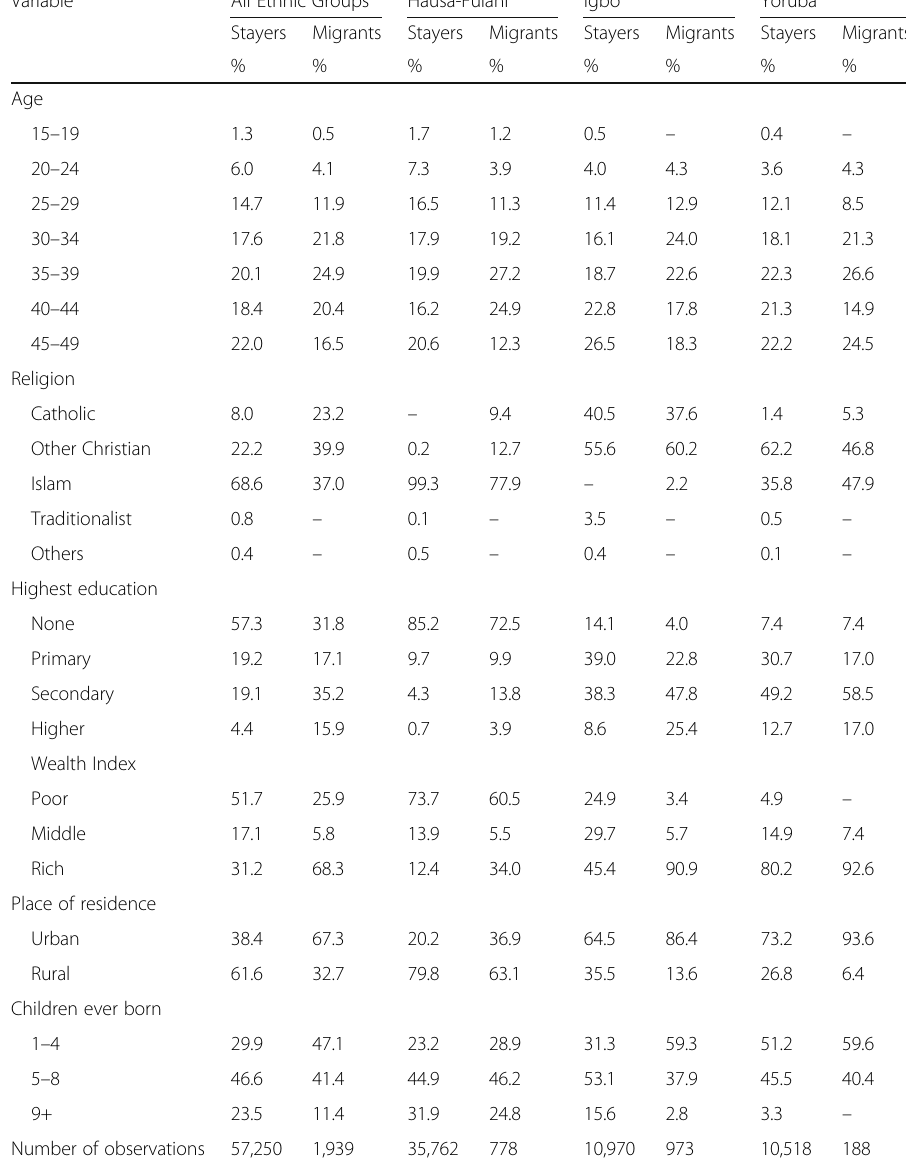
Table 1 Sociodemographic characteristics of stayers and migrants Variable All Ethnic